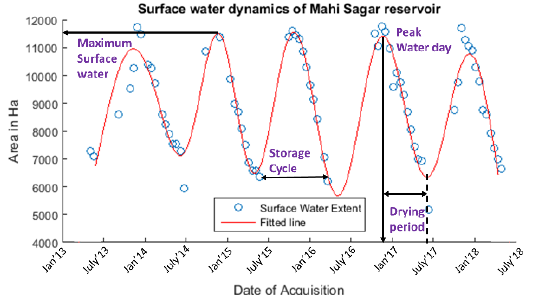
Figure 4: Time series plot of surface water extent and Modified Gaussian model fit derived over Mahi Sagar reservoir, Gujarat from GEE.